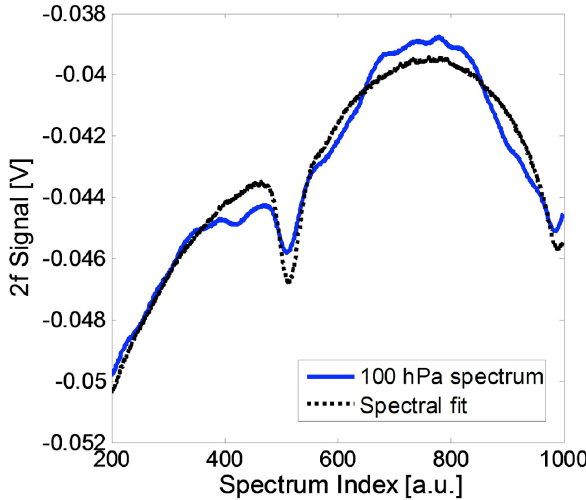
Fig. 8. Second harmonic spectrum at reduced pressure (100hPa) Figure 8. Second harmonic spectrum at reduced pressure (100 hPa) with zero NH 3 signal 2 with zero NH 3 signal recorded at 10Hz time resolution. recorded at 10 Hz time resolution. 3